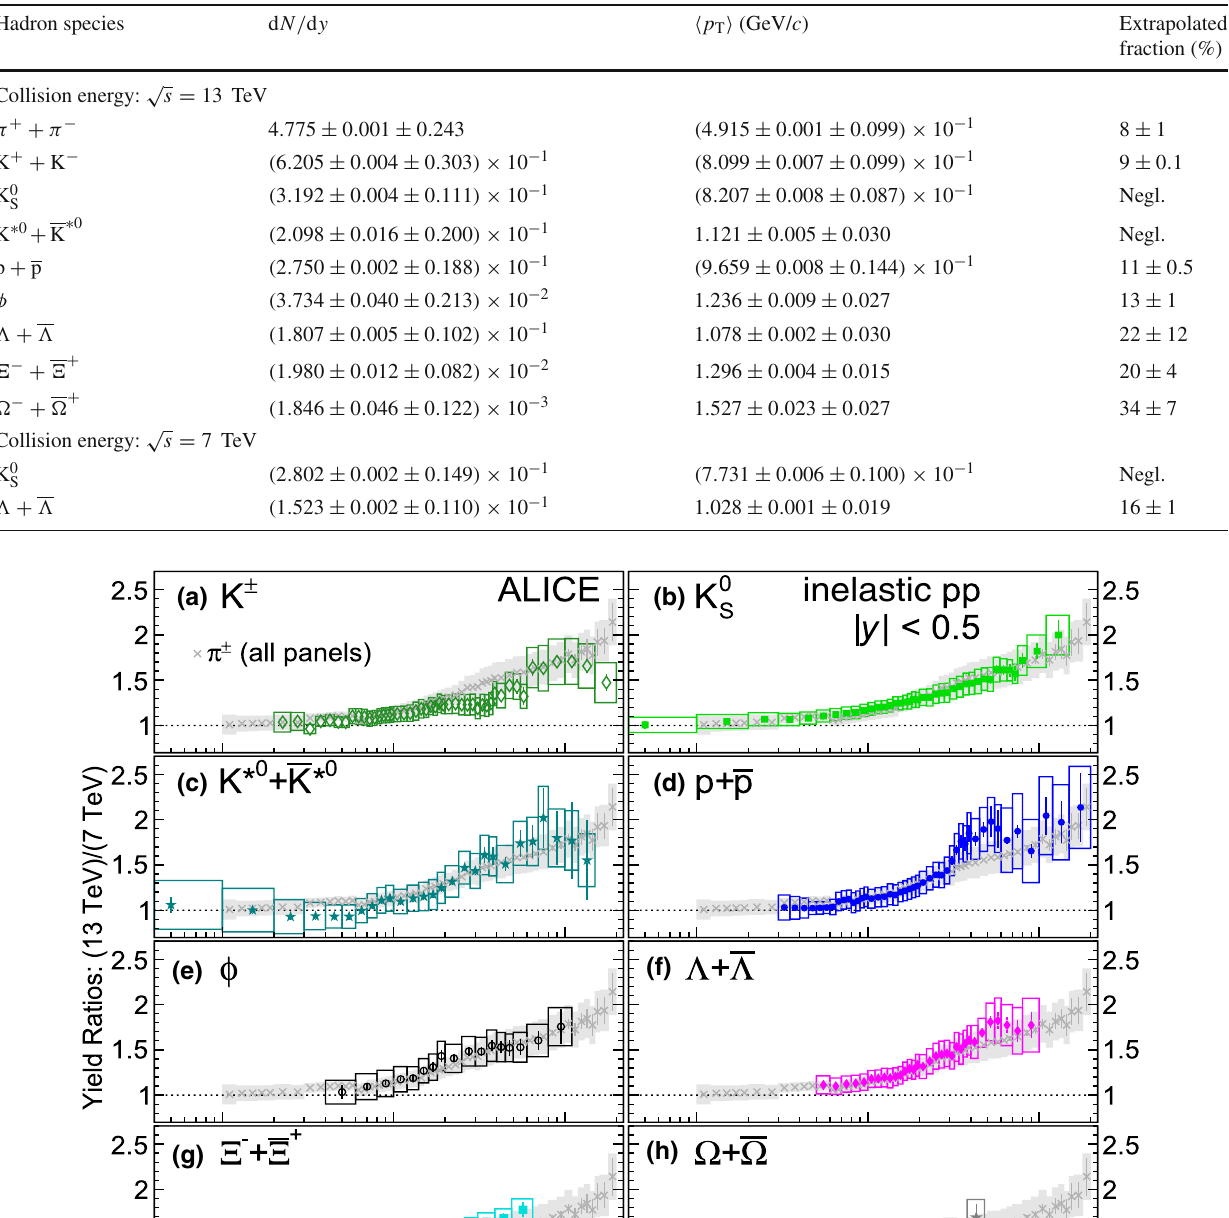
Table 8 Average transverse momentum (cid:10) p T (cid:11) and p T -integrated yield d N / d y values for light-flavor hadrons measured in pp collisions at √ s = 13 TeV and 7 TeV. The first uncertainty is statistical and the second is systematic (including the low- and high- p T extrapolation).